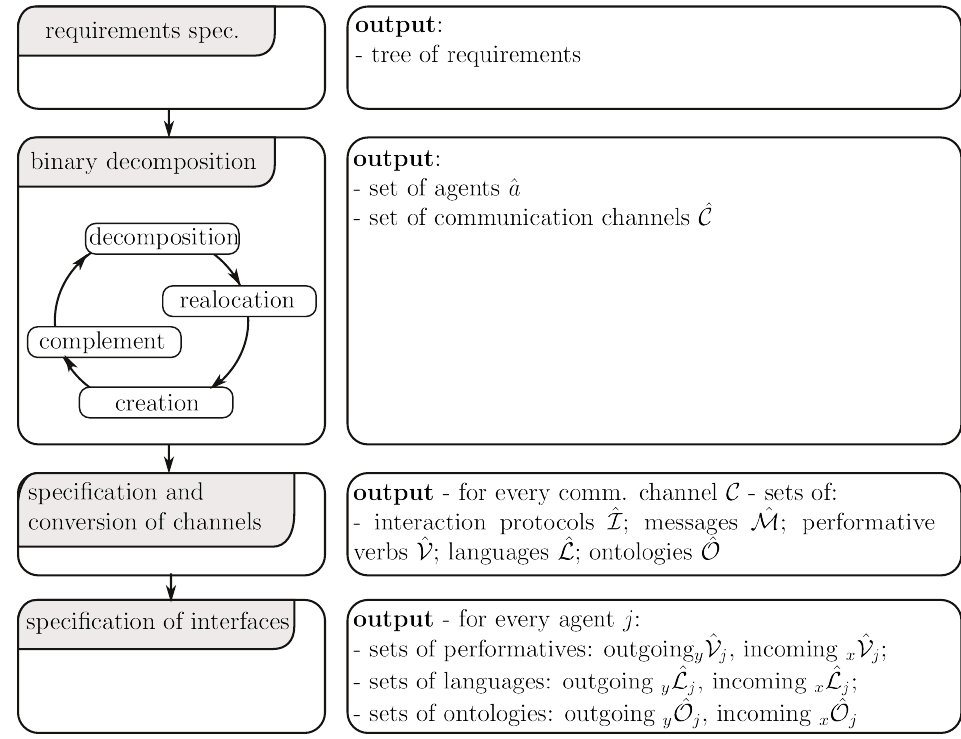
Figure 4. Binary decomposition